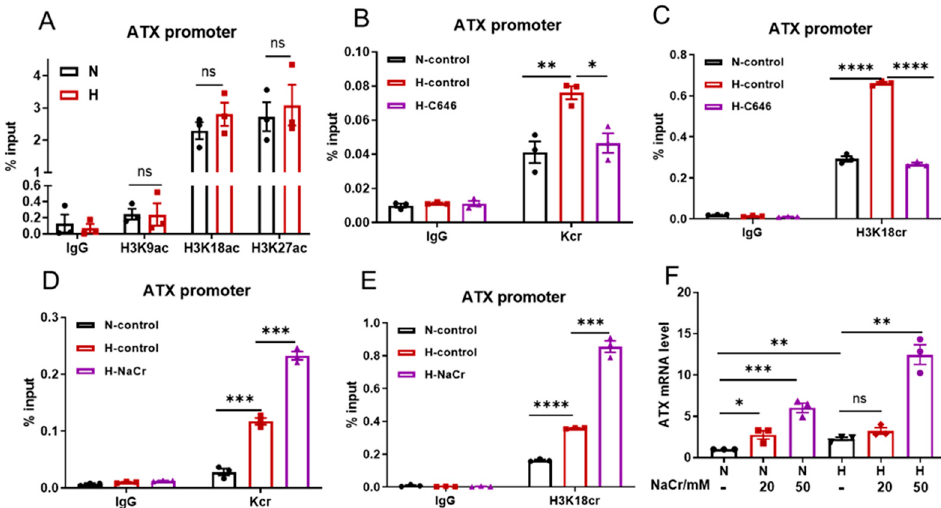
Figure 6. Histone crotonylation contributes to the hypoxic induction of ATX. ( A ) SW480 cells were cultured under normoxic (N) or hypoxic (1% O 2 , H) conditions for 24 h, and then subjected to ChIP assays with anti-H3K9ac, anti-H3K18ac, or anti-H3K27ac antibodies to detect the enrichment of the indicated histone modifications in the ATX promoter. ( B – E ) SW480 cells were cultured under normoxic (N) or hypoxic (1% O 2 , H) conditions in the absence or presence of the p300 inhibitor C646 (25 µM) ( B , C ) or NaCr (50 mM) ( D , E ) for 24 h and then subjected to ChIP assays with anti-Kcr ( B , D ) or anti-H3K18cr ( C , E ) antibodies to detect the enrichment of the indicated histone modification in the ATX promoter. The PCR amplification of immunoprecipitated DNA fragments in ChIP assays ( A – E ) was performed with primers for site 1. ( F ) SW480 cells were cultured under normoxic (N) or hypoxic (1% O 2 , H) conditions in the presence of NaCr (0, 20, or 50 mM) for 24 h. ATX mRNA levels were measured using RT-qPCR. And the data shown are the mean ± SEM of n = 3 independent experiments. p -values were calculated using two-sided unpaired Student’s t tests ( A – E ) and a two- way ANOVA with Tukey’s t test ( F ). ns, not signi fi cant; * p < 0.05; ** p < 0.01; *** p < 0.001; **** p < 0.0001.